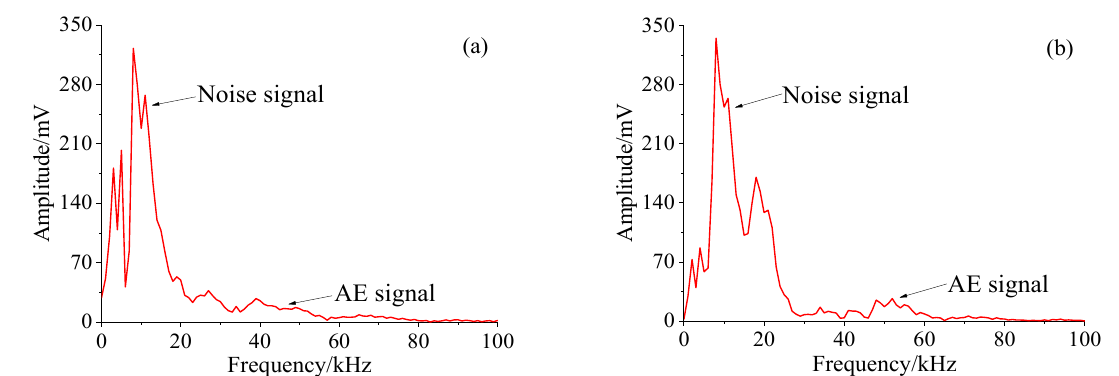
Figure 14. Frequency spectrum of AE by the PLB method: ( a ) Lead-breaking position is 50 mm; ( b ) lead-breaking position is 150 mm.